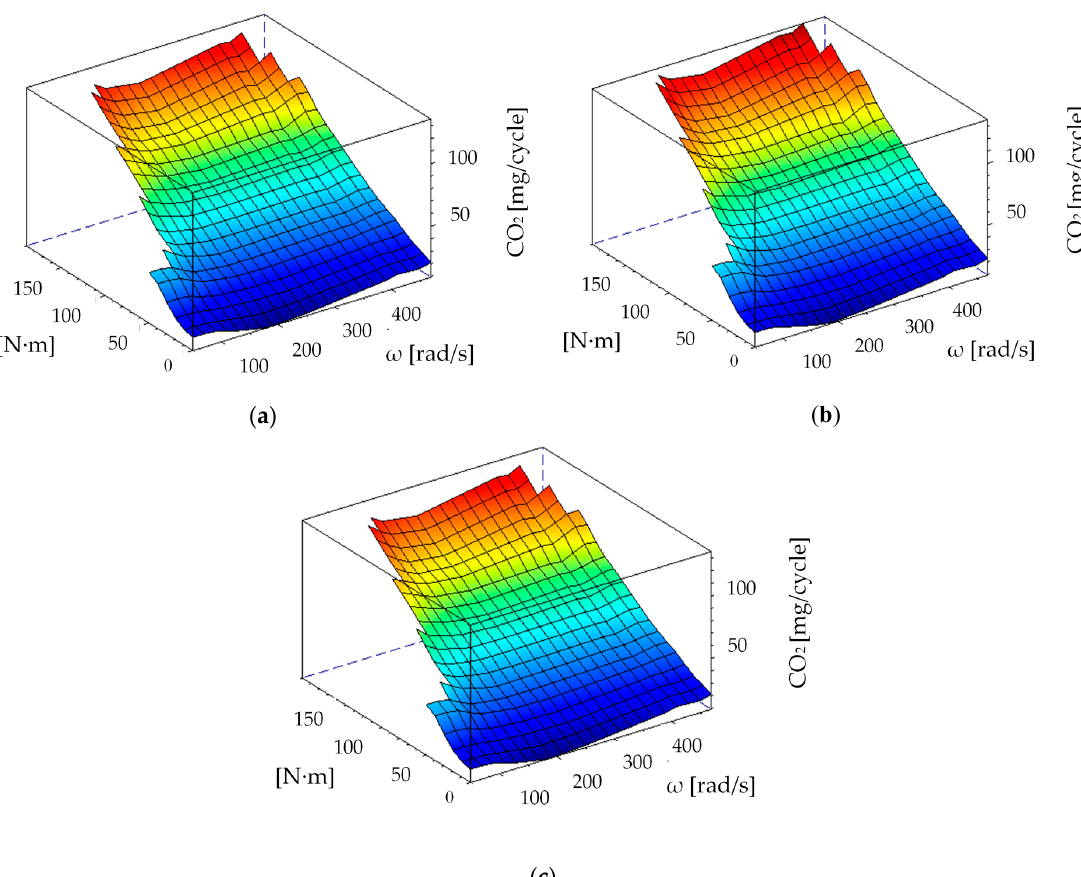
Figure 7. Carbon dioxide emissions per diesel, FAME, and biobutanol for one injection cycle: ( a )—Diesel; ( b )—FAME; ( c )—Butanol.